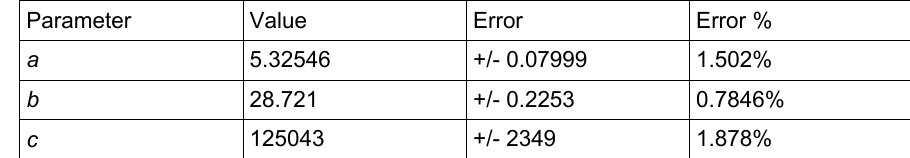
Table 1 – Fit for parameters a, b and